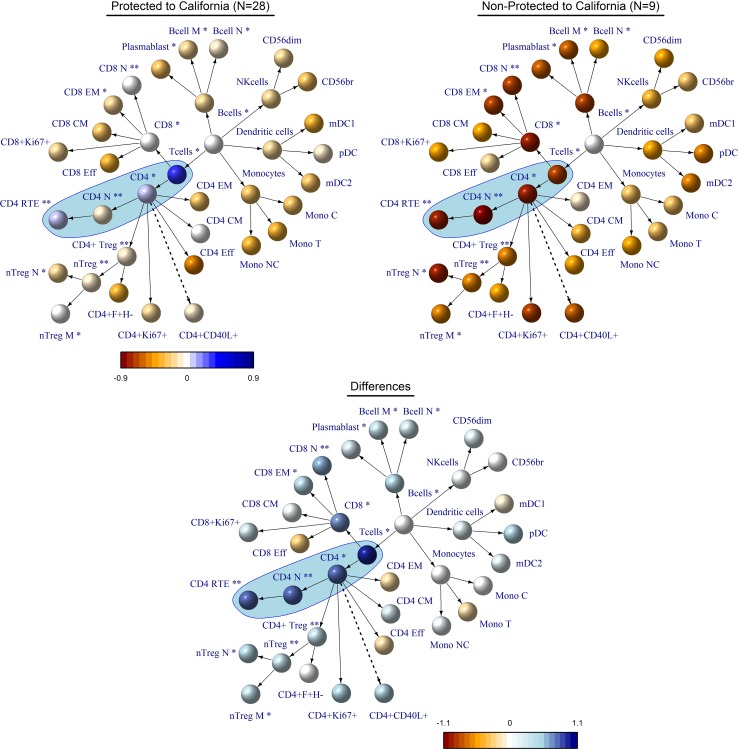
Hierarchical network representation of immune cell-subset counts at baseline with respect to A(H1N1)pdm09 protection in the pilot study.We monitored 36 immune cell subpopulations in A(H1N1)pdm09 sero-negative donors and compared donors who became either sero-protected or not at day 21 after vaccination. We observe a number of cell populations for which the counts are significantly different between protected and non-protected donors, specifically on the CD4+ T cell axis. The colors indicate the relative median counts of the groups. Significant differences were determined using the Wilcoxon-Test and indicated with * for p<0.05 and ** for p<0.01.